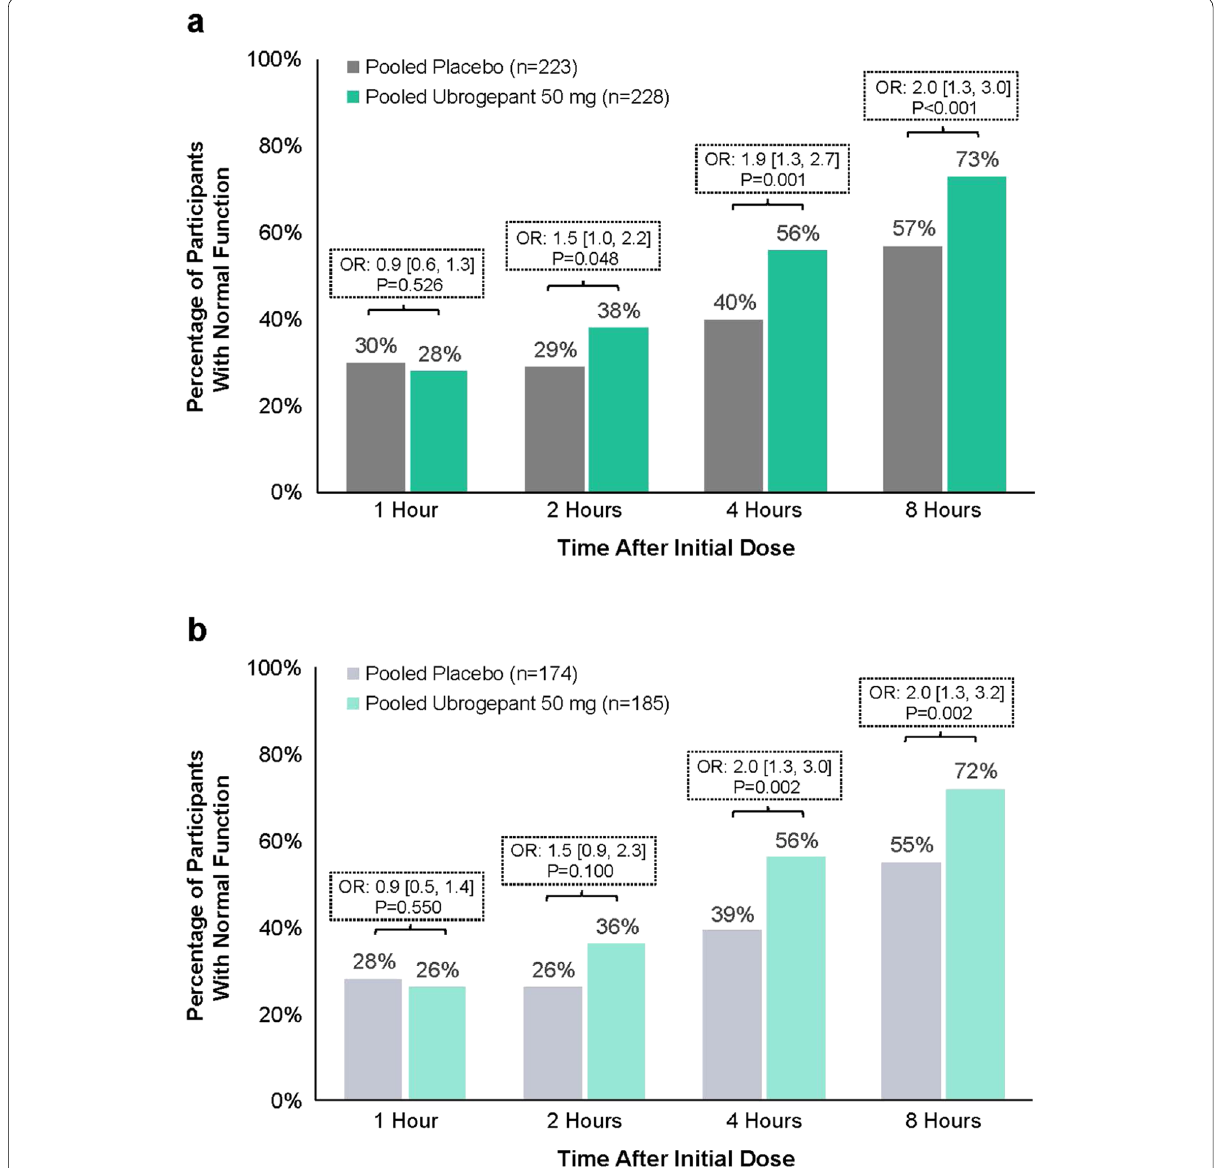
Fig. 2 Proportion of participants reporting ability to function normally on the FDS in ( a ) TIR and ( b ) TIR due to insufficient efficacy groups. FDS, Functional Disability Scale; OR, odds ratio; TIR, triptan insufficient responder. P -values are based on logistic regression with treatment group, use of medication for migraine prevention, and baseline headache severity as covariates; last observation carried forward approach was used to input missing values post